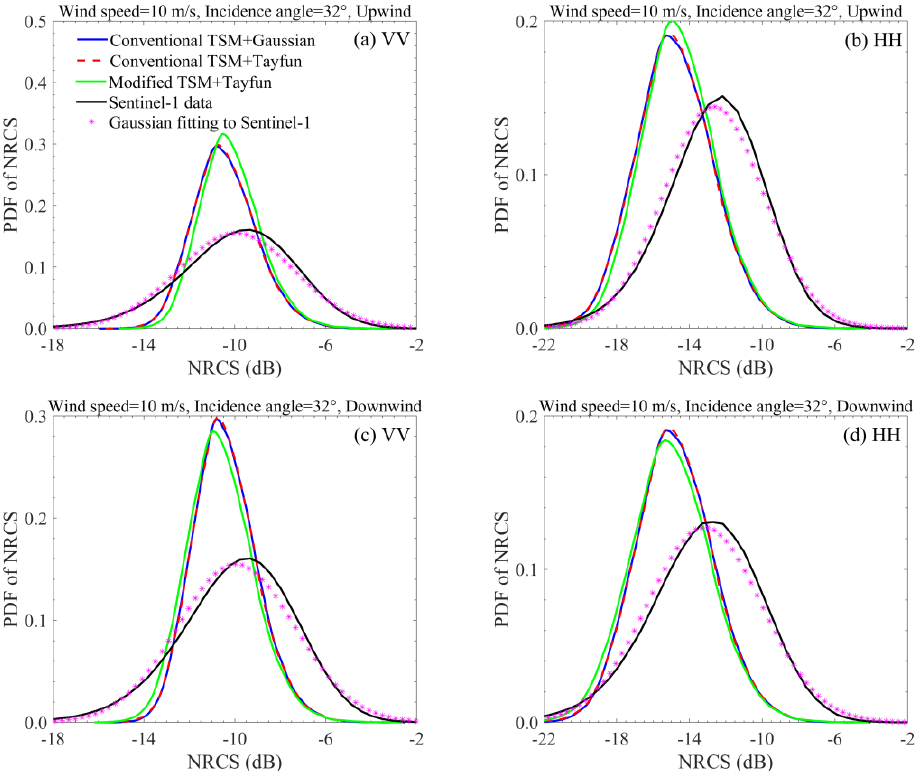
Figure 12. Examples of the pdfs for scattering predicted based on the conventional TSM + Gaussian sea surface, the conventional TSM + Tayfun sea surface, and the modified TSM + Tayfun sea surface and their comparison with Sentinel-1 data and Gaussian fitting to Sentinel-1 data at a 32° incidence angle and 10 m/s wind speed ( a , b ) in the upwind direction under VV and HH polarizations and ( c , d ) in the downwind direction under VV and HH polarizations. Blue solid curve, conventional TSM + Gaussian sea surface; red dashed curve, conventional TSM + Tayfun sea surface; green solid curve, modified TSM + Tayfun sea surface; black solid curve, Sentinel-1 data; magenta star, Gaussian distribution fitting to Sentinel-1 data.